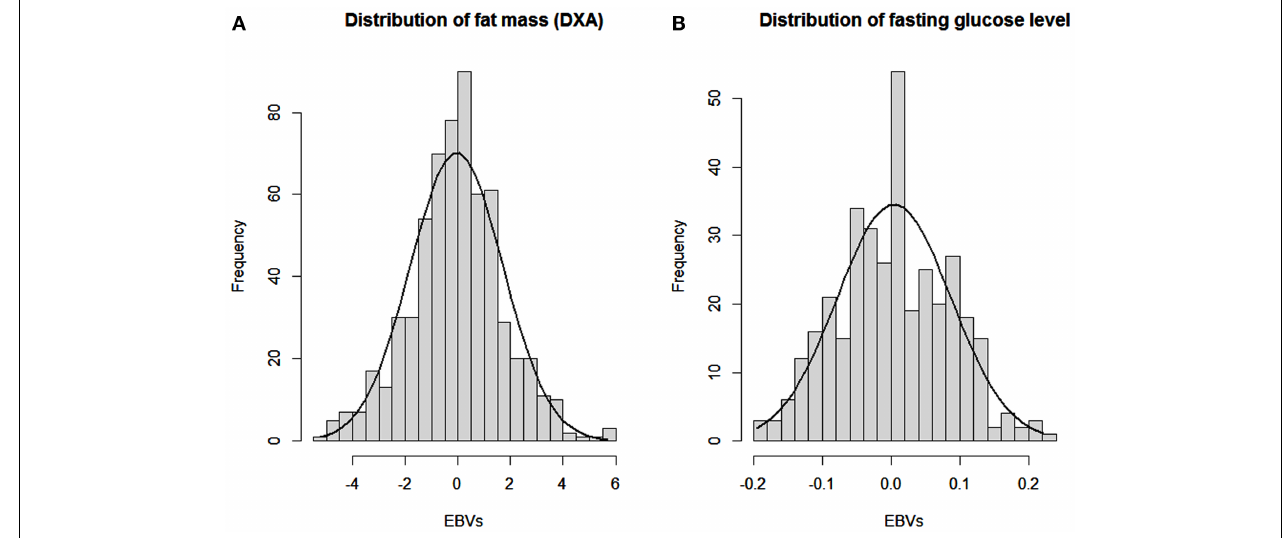
FIGURE 4 | Distributions of estimated breeding values for percentage of fat (DXA fat) and fasting glucose level (GLU). Distributions of estimated breeding values (EBV’s) for (A) percentage of fat at DXA scanning and (B) fasting glucose